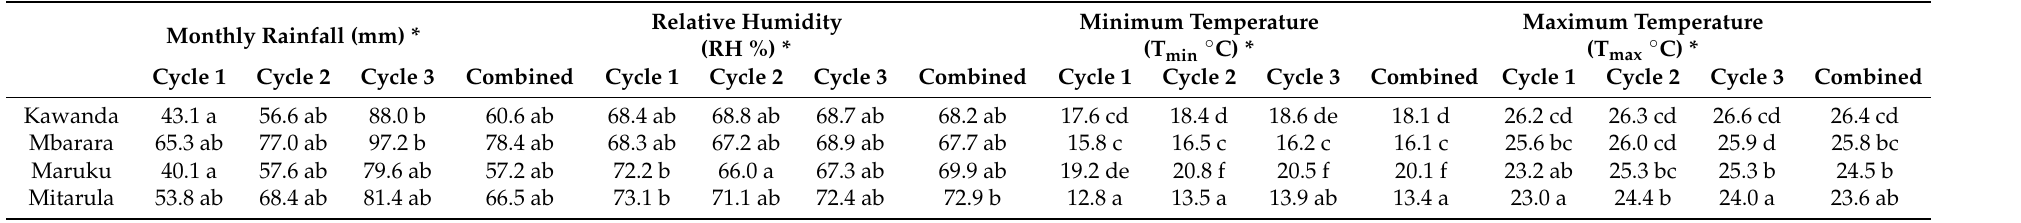
Table 6. Environmental variables at four test sites in Uganda and Tanzania during the trial period 2016 to 2018.